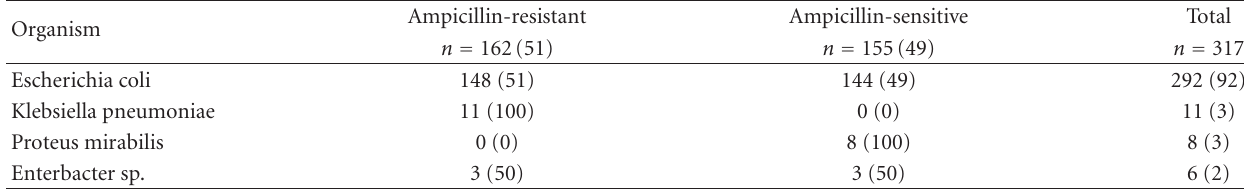
Table 1: Uropathogens identified by culture with antibiotic sensitivities in acute antepartum pyelonephritis . Data are reported as n (%). Organism